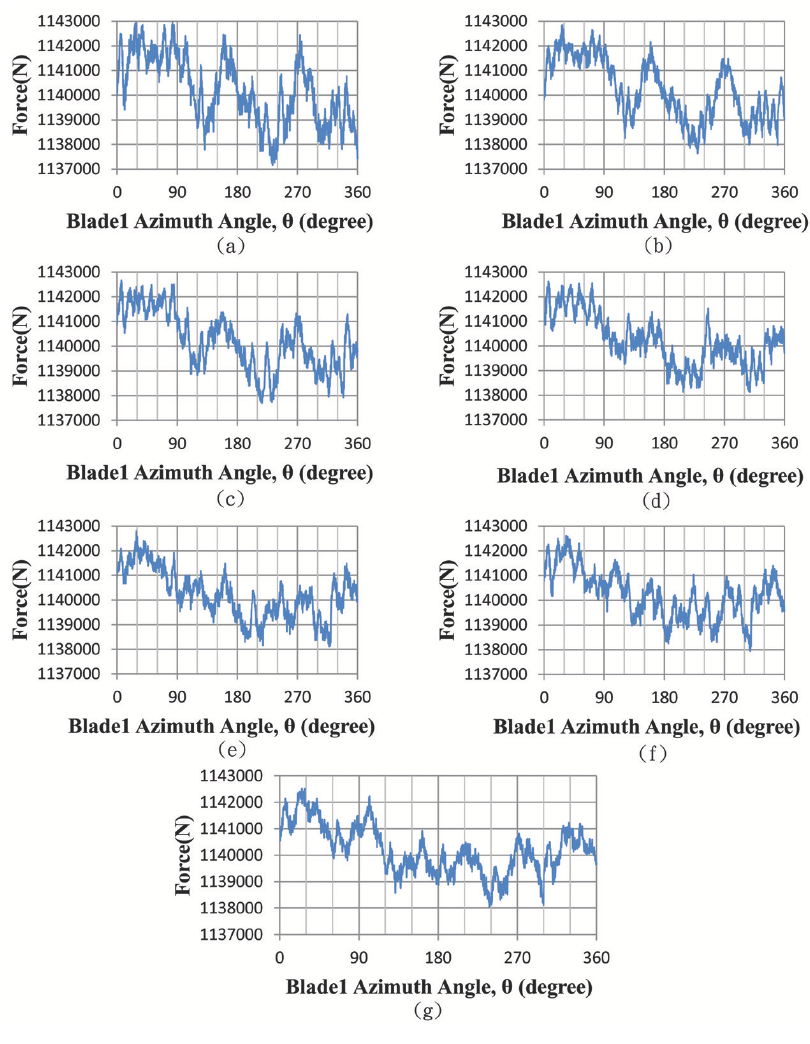
Figure 14. Turbine loads versus the azimuth angle due to different phase angles. ( a ) 0 ◦ ; ( b ) 10 ◦ ; ( c ) 20 ◦ ;